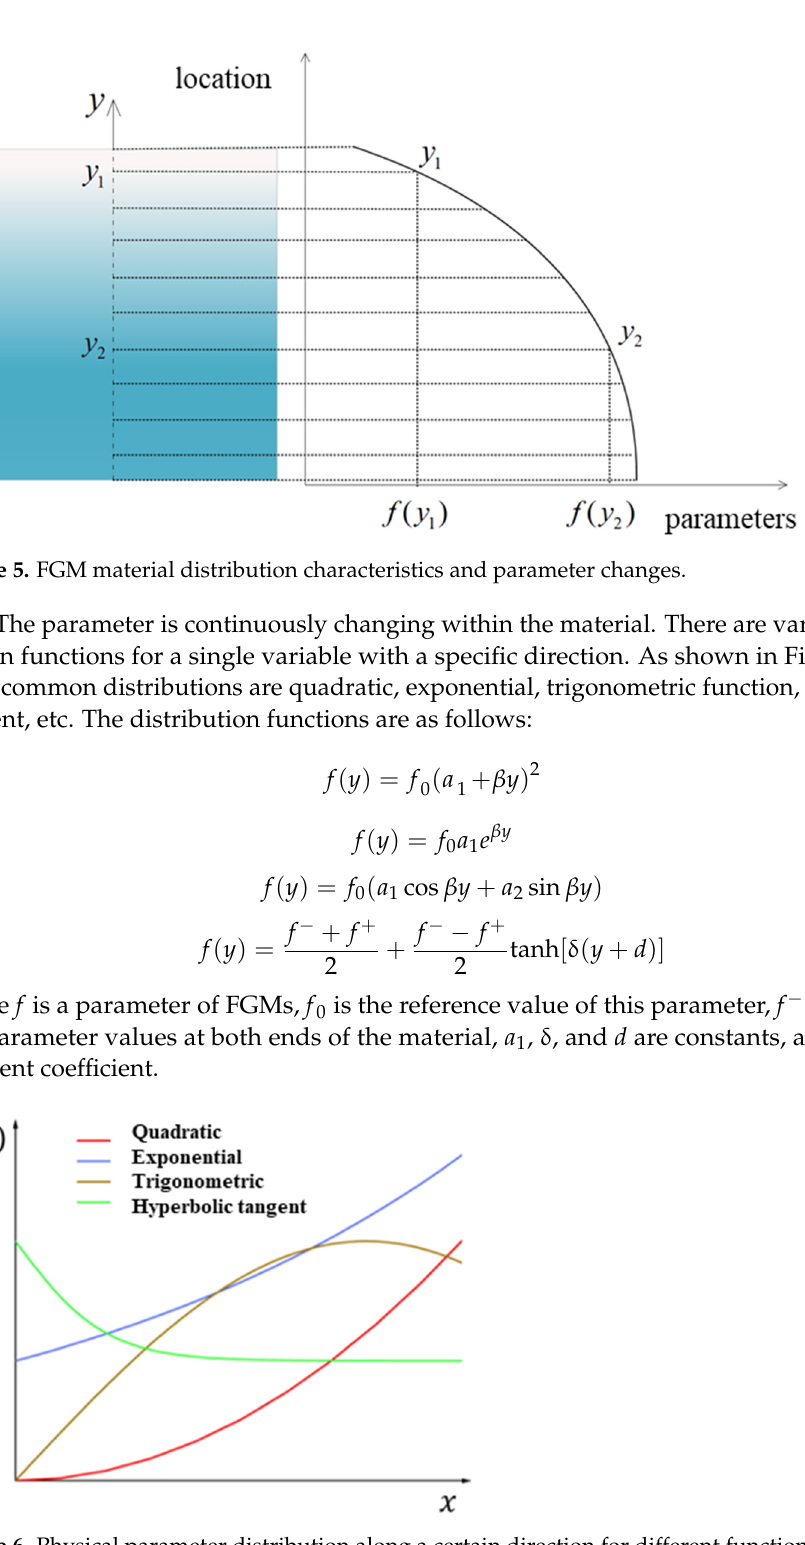
Figure 6. Physical parameter distribution along a certain direction for different functions.